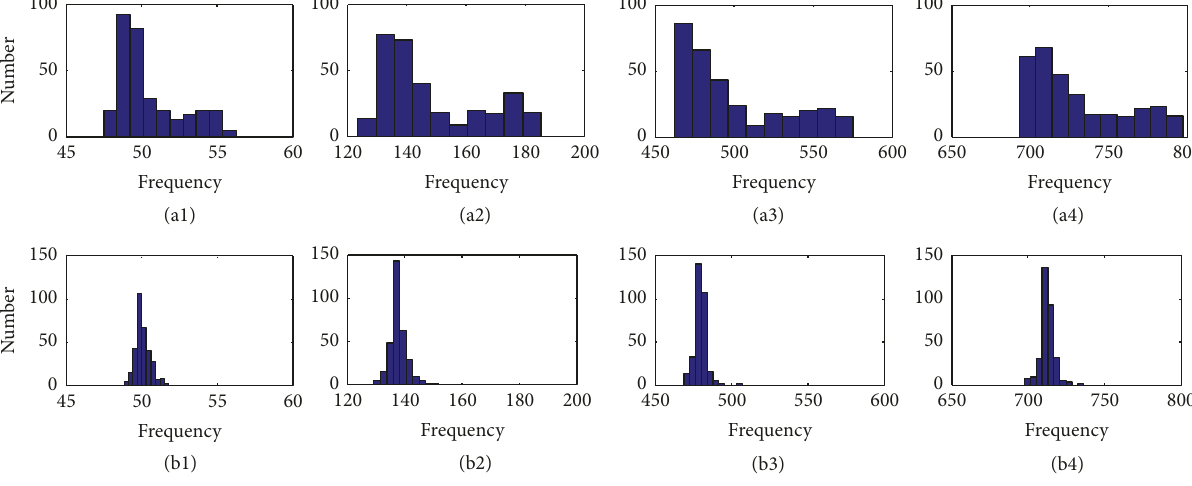
Figure 11: Histograms of the modal frequencies before and after the elimination of temperature effects. (a1) 1st modal frequency before eliminating temperature effect; (a2) 2nd modal frequency before eliminating temperature effect; (a3) 3rd mode modal frequency before eliminating temperature effect; (a4) 4th modal frequency before eliminating temperature effect; (b1) 1st modal frequency after eliminating temperature effect; (b2) 2nd modal frequency after eliminating temperature effect; (b3) 3rd modal frequency after eliminating temperature effect; (b4) 4th modal frequency after eliminating temperature